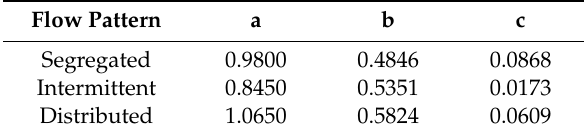
Table 3. Parameters for liquid holdup calculation in a horizontal pipe.